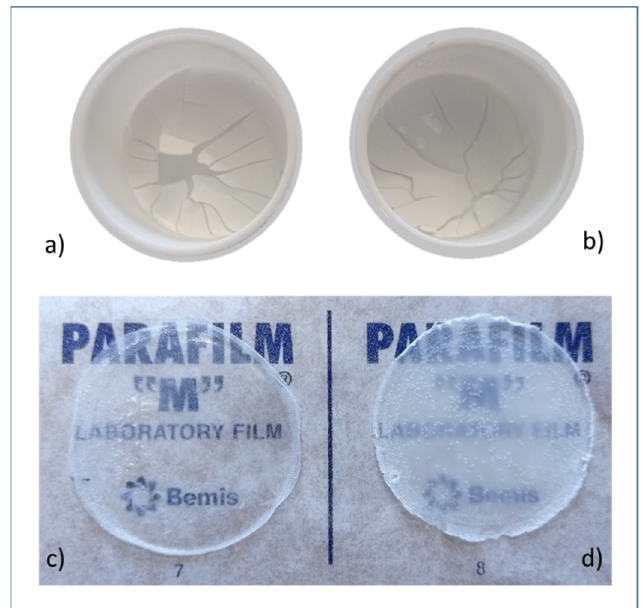
Figure 6. Pictures of PLA films obtained by solution casting at 40 °C ( a , b ) and 60 °C ( c , d ) of water dispersions with SDS and starch ( a , d ) or SYN ( b , c ).